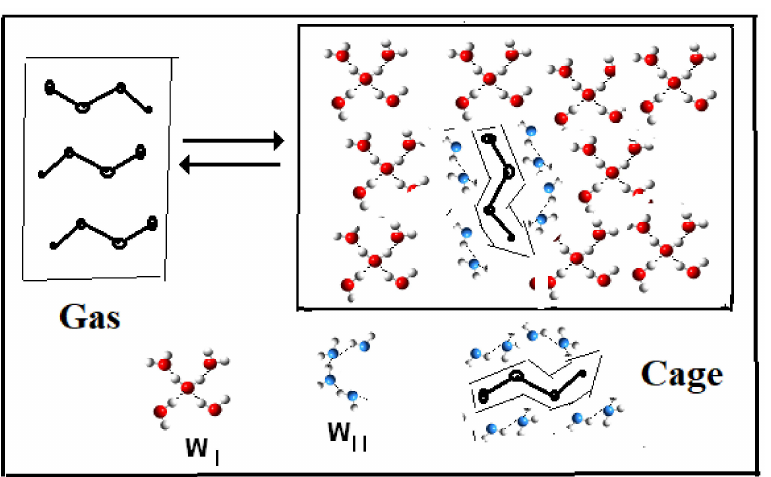
Figure 8. Change in kinetic thermal energy (entropy change) for gas trapping in a cage and for passage of vapor to liquid